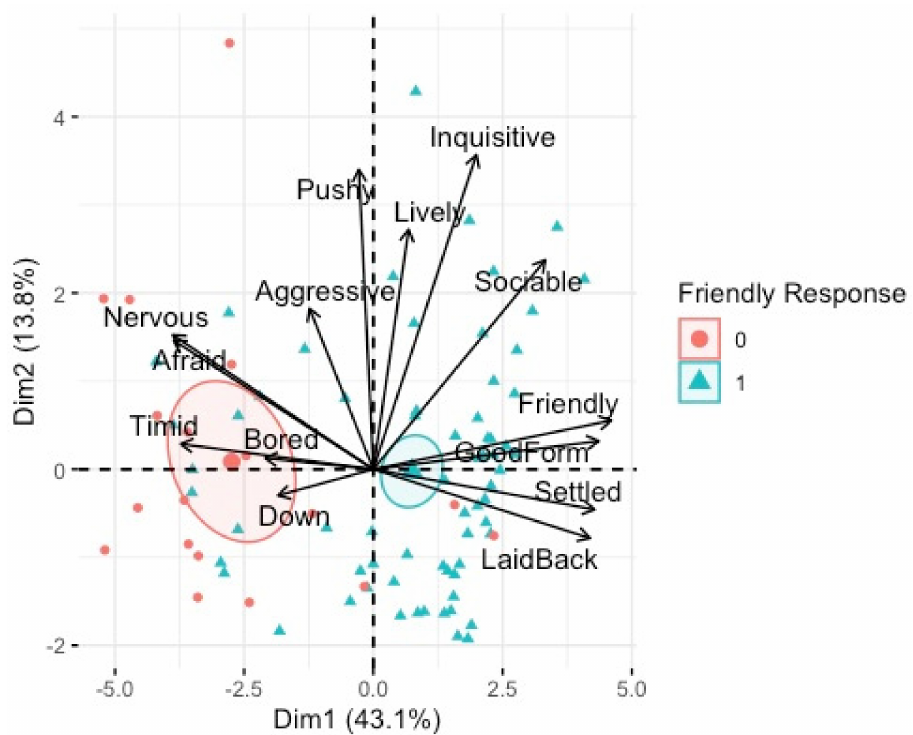
Figure 5. PCA bi-plot of QBA terms associated with individual horses who displayed a friendly response to the voluntary animal approach test (1) or not (0). Dimension 1 (mood) and Dimension 2 (energy).